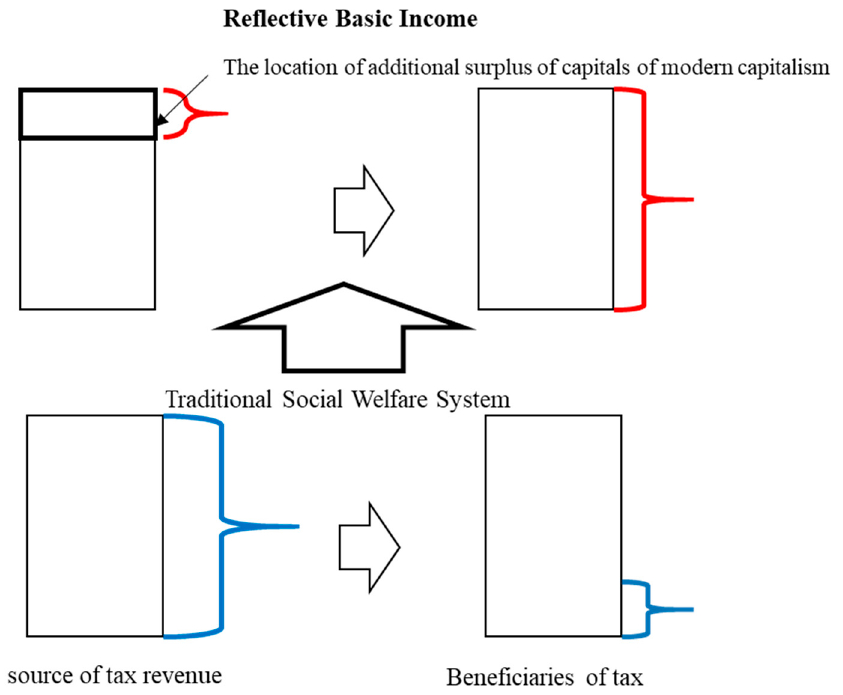
Figure 3. Reflective basic income; source of tax revenue and beneficiaries of tax.